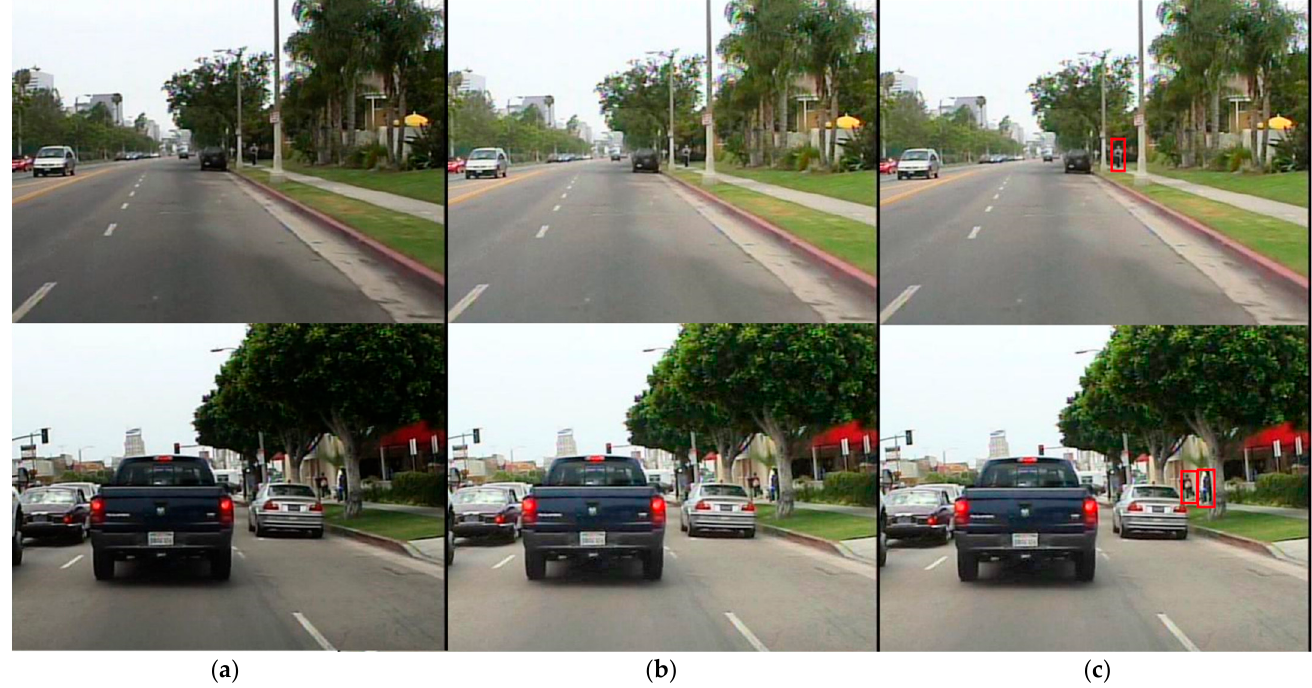
Figure 5. Detection comparisons before and after applying ALTM. ( a ) Original test images, ( b ) preprocessed images with tone mapping, and ( c ) detection of pedestrians . Red boxes denote the detections.